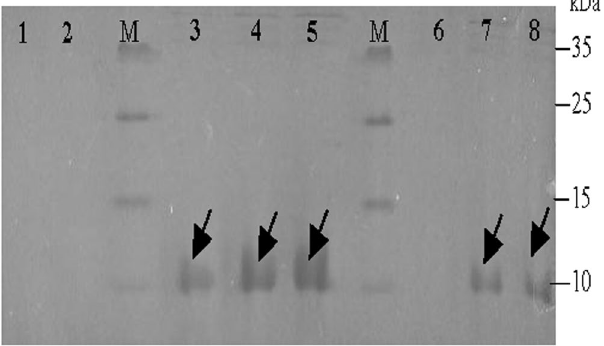
Figure 5. SDS-PAGE analysis of the recombinant protein rEpl1-p from GS115-Epl1. Lanes 1,2,6. The supernatant of control transformant GS115-pPIC9K induced for 6 h; lanes 3,4,5. The supernatant of transformant GS115-Epl1 induced for 2, 4, 6 h; lane 7,8. The supernatant of transformant GS115-Epl1 induced for 1 h; the concentration of methanol was 0.5% (v/v). M. Protein Marker. Full-length gels are presented in Supplementary Figure